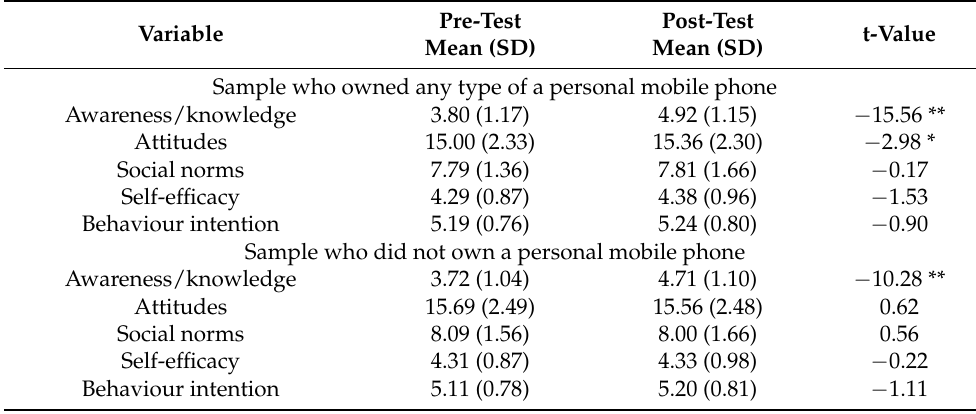
Table 5. Awareness/knowledge, attitudes, social norms, self-efficacy, and behaviour intentions of the sample based on the type of mobile phone ownership and